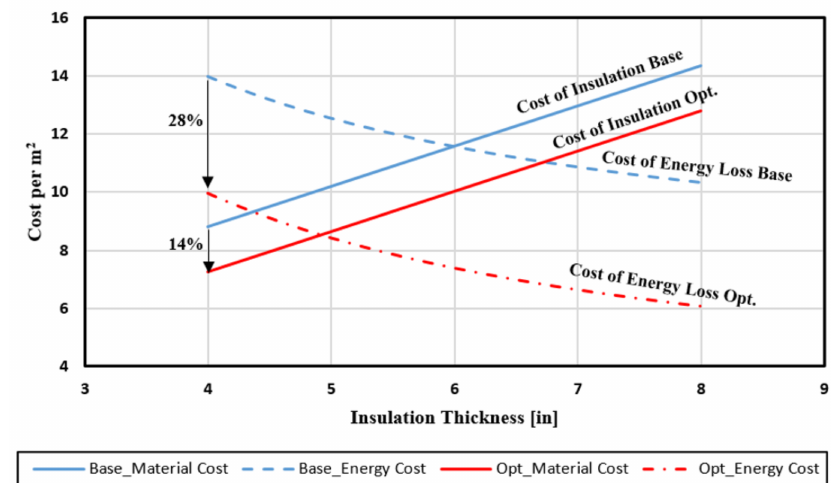
Figure 18. Effects of optimization on insulation and energy